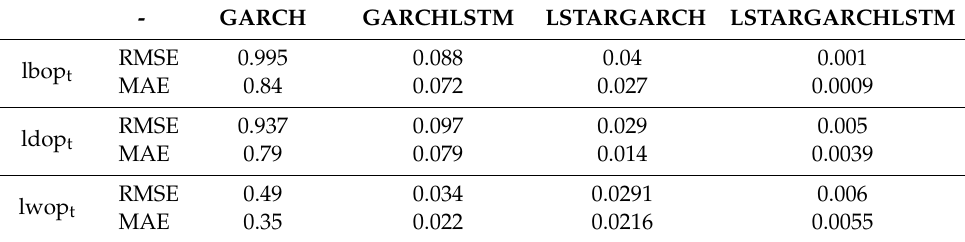
Table 8. In-step forecast results.